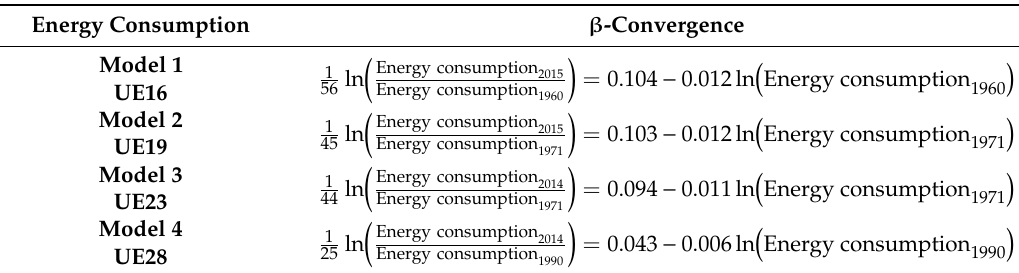
Table 3. Mathematical presentation for Equation